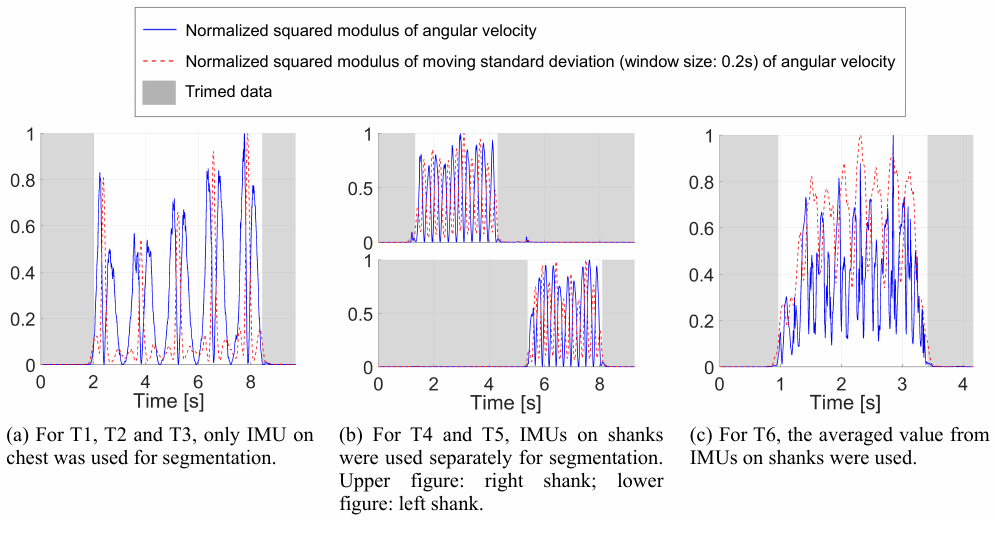
Upper figure: right shank; lower figure: left shank. Figure 5. Data segmentation. Threshold at 0.1 followed by morphologically close on the binary (length: 1 s) are then